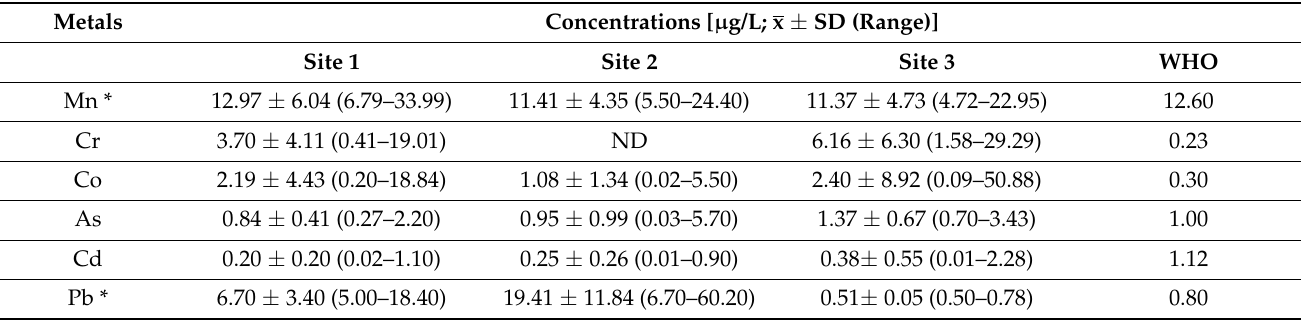
Table 1. Trace metals in blood of obese females living around study sites in µ